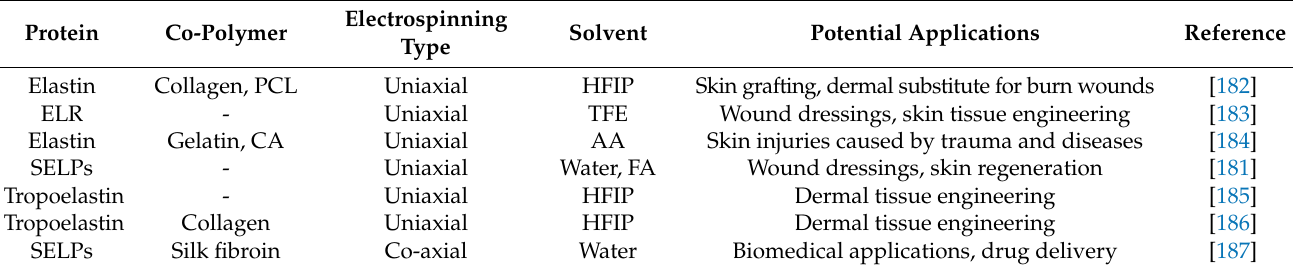
Table 3. Electrospun elastin-based fiber mats for wound healing